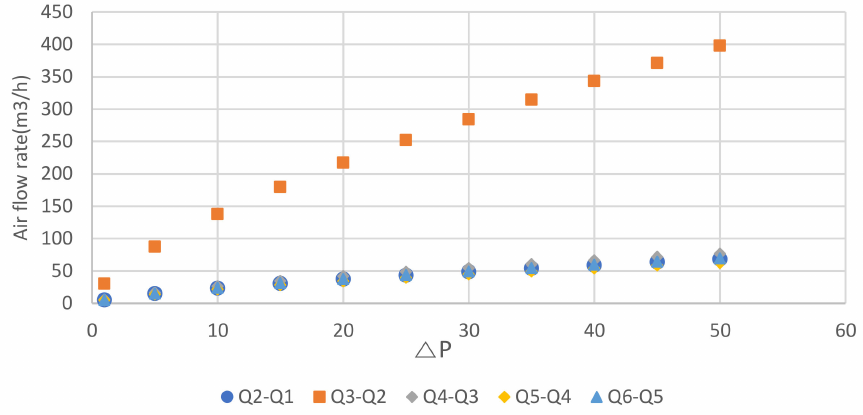
Figure 5. Air flow rate difference with various pressure differences through the infiltration